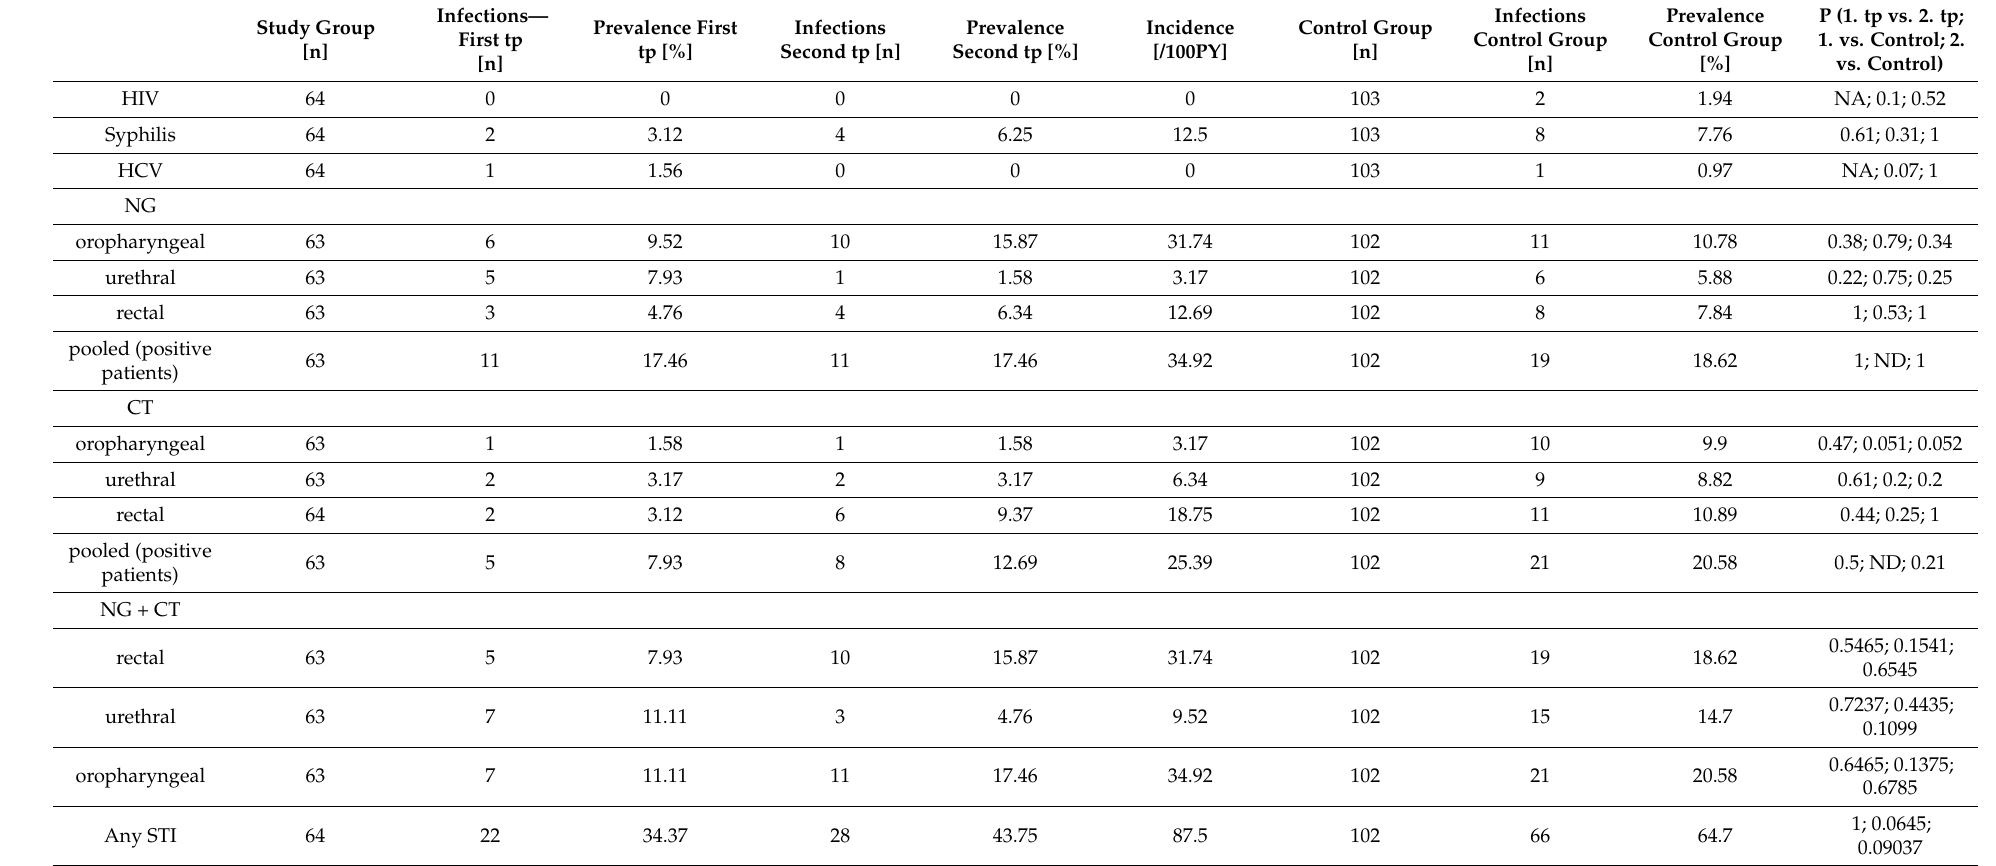
Table 3. Confirmed STIs and comparison between timepoints, groups and anatomical